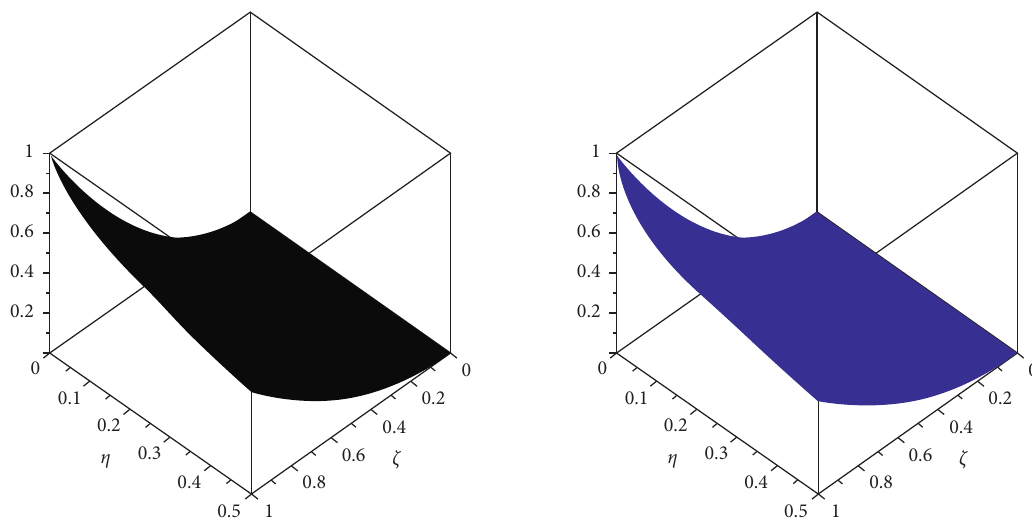
Figure 8: The approximate result graphs of problem 4.3, at δ � 0 . 6 and